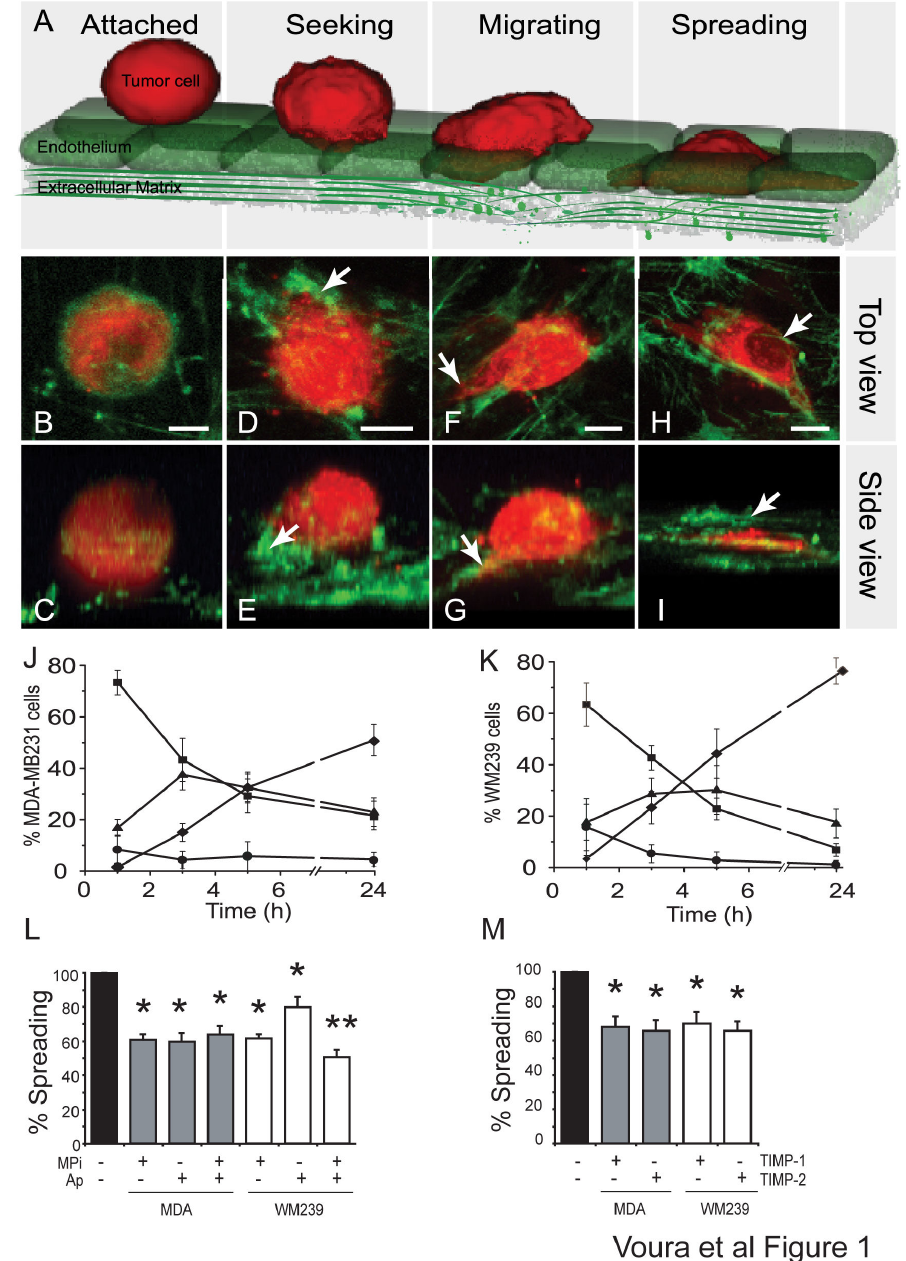
Figure 1. Protease inhibitors reduce tumor cell transendothelial migration. (A) Model of extravasation stages. Three- dimensional confocal rotations or maximum projections of DiI labeled WM238 (red) at stages of extravasation from the top (B, D, F and H) and side (C, E, G, and I). BODIPY FL phallacidin (green) shows actin, and arrows indicate processes. Bars=10 μm. Note that confocal rotations or maximum projections allow for the fluorescence in all the focal planes to be seen in one image. Therefore, the ‘top view’ of the ‘attached’ stage allows for the visualization of actin in both the tumor cells and the endothelial cells in the same image, even if the latter cells are well below the top focal plane of the tumor cell. For reference please also compare with the ‘side view’ panel. Percent attached (●), seeking (■), migrating () and spreading ( ◆ ) cells at 1, 3, 5 and 24 hours for MDA-MB231 (J) and WM239 (K). (L) Percent spreading MDA-MB231 (grey bars) and WM239 (white bars) relative to the no inhibitor control (black bar). Proteinase inhibitors MPi (20 μM) and aprotinin (100 U) were used. A * Indicates a significant p-value compared to controls and ** indicates significant p-value relative to both controls and MPi or aprotinin alone. (M) The reduction in spreading cells with recombinant TIMP-1 or TIMP-2 (each at 2 μg/mL). doi: 10.1371/journal.pone.0078413.g001 PLOS ONE |